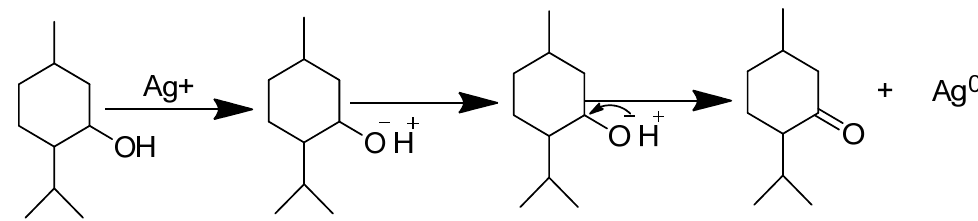
Figure 1. Adapted with permission from [76]. Copyright (2022) Elsevier Heliyon. Phyto-reduction of Ag + to AgNPs by terpenoids.